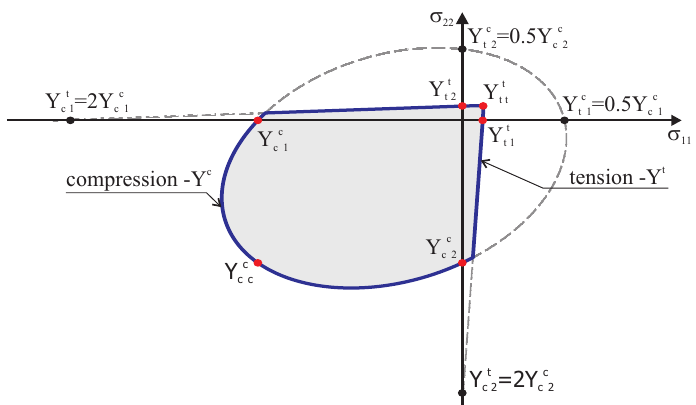
Figure 3. The proposed criterion and material parameters determining the surfaces.